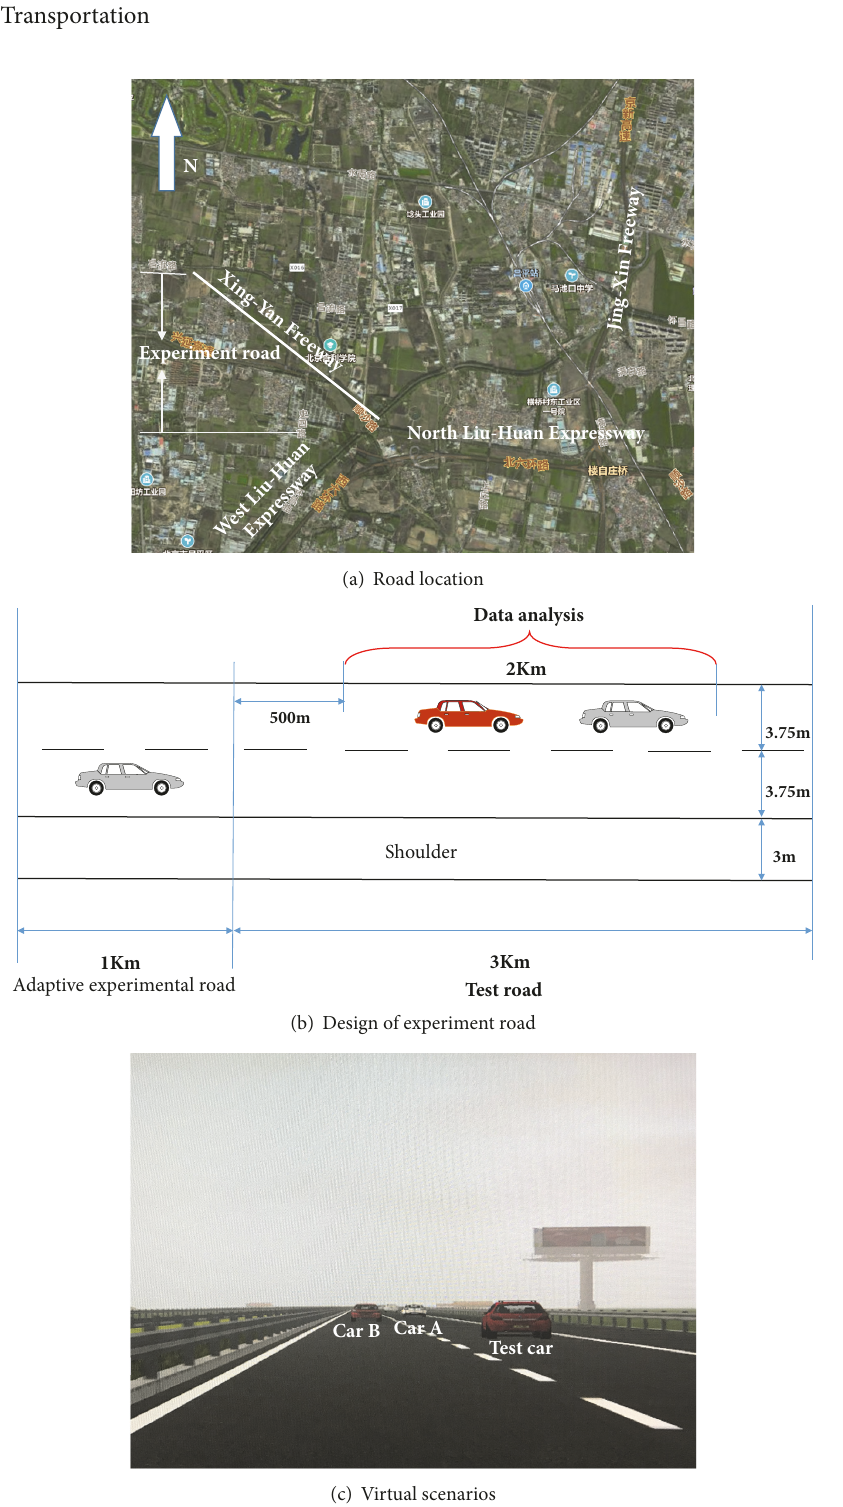
Figure 5: Overall view of simulation